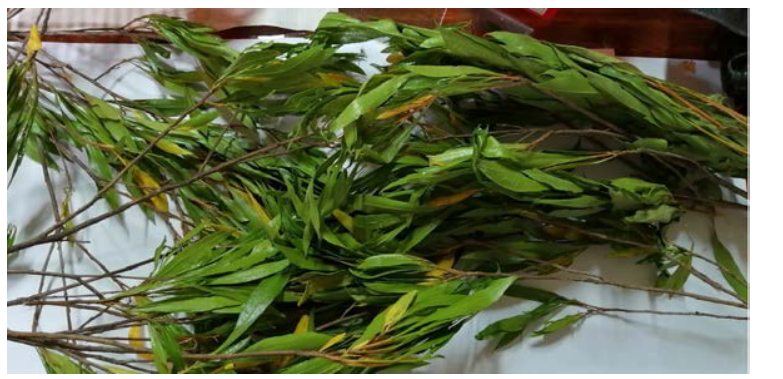
Fig. 1. Aerial parts of Dodonaea viscosa